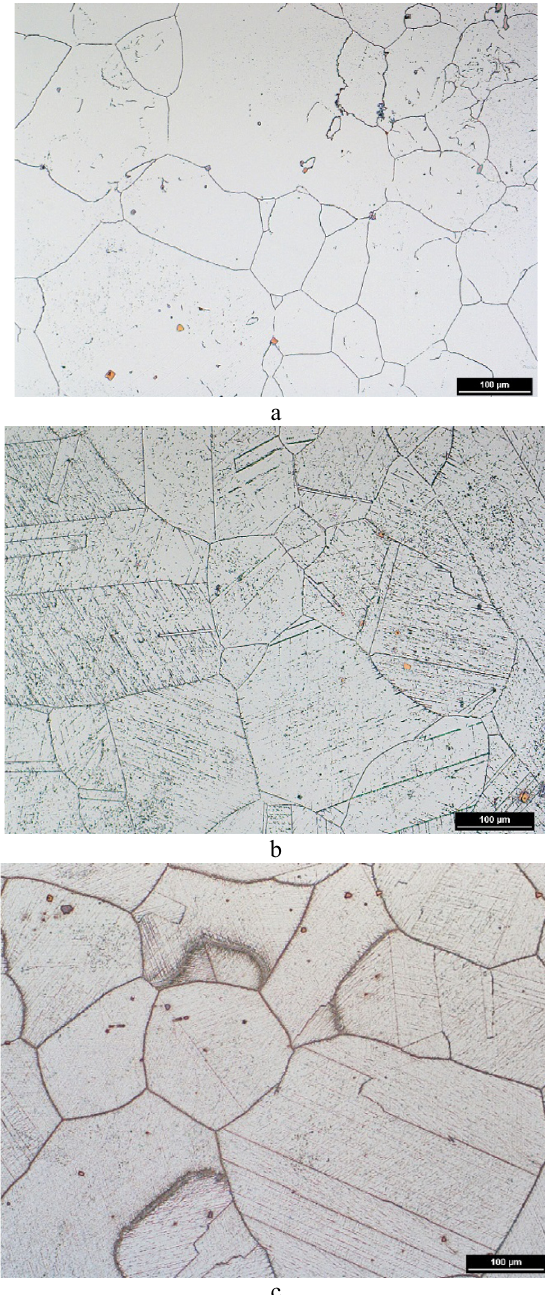
Fig. 8. Microstructure of base metal of Alloy 800 H on the cross- section of specimens: (a) in as-received state, (b) after exposure of 1500 hours in impure helium at 760 ° C in the furnace, (c) after exposure in HTHL during 264 hours of the test operation.